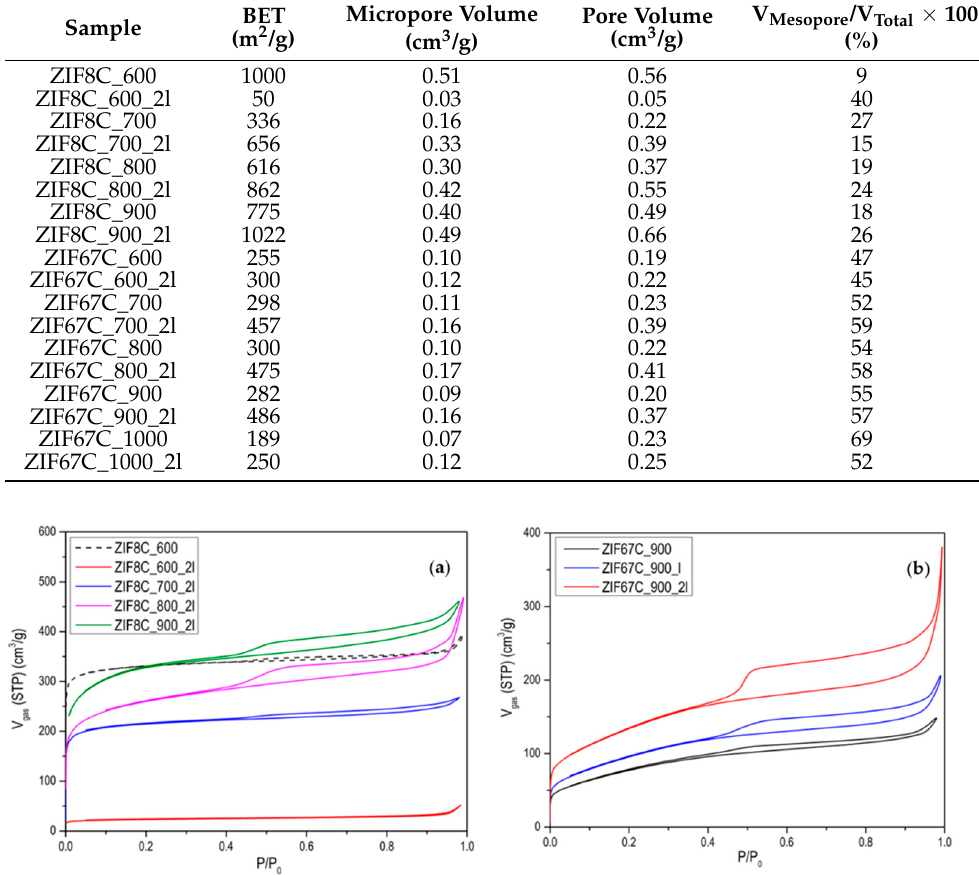
Figure 2. ( a ) Normalized TG profile of ZIF-67 in air atmosphere after the treatment in Ar atmosphere; ( b ) MS signal for m / z 30 (NO), m / z 46 (NO 2 ) and m / z 44 (CO 2 ). Table 1. Textural properties from the obtained carbons.